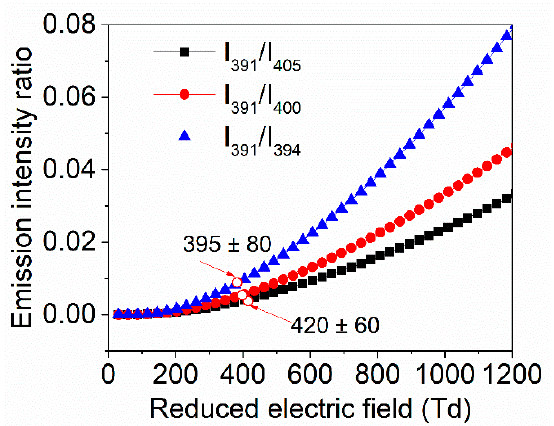
Figure 9. The intensity ratios of I 391 / I 405 , I 391 / I 400 , and I 391 / I 394 as function of E/N.